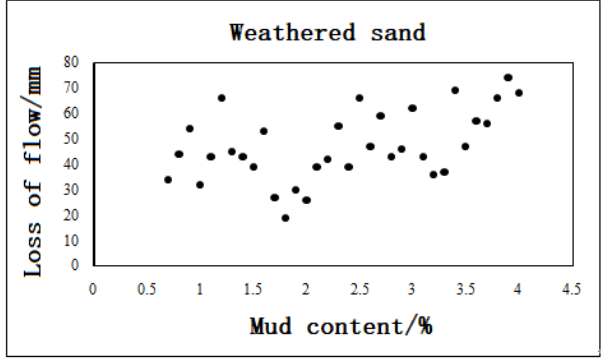
Figure 6. Flowability loss of weathered sand with different mud content .